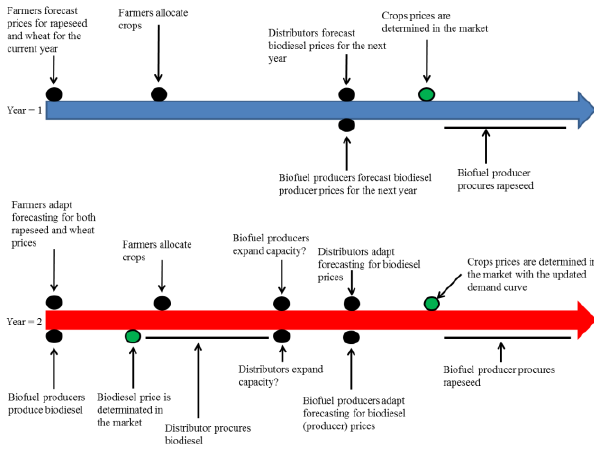
Figure 2. Model narrative (adapted from Moncada et